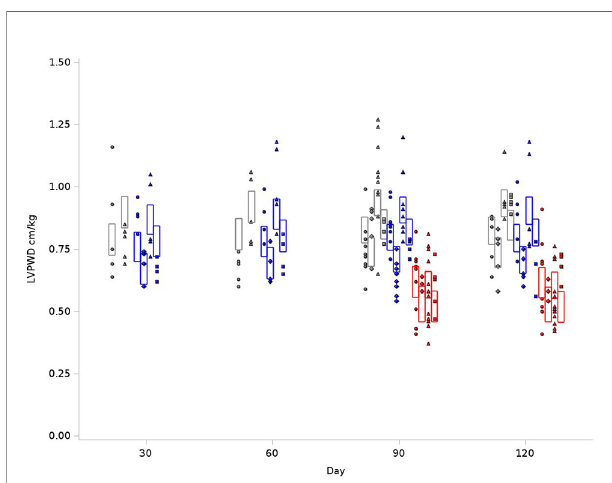
FIGURE 5 | Graphical representation of values for Left Ventricular Posterior Wall Thickness at End Diastole (LVPWD) in rats at 4 time points (X-axis). The rats were measured at 4 time points: 30, 60, 90 and 120 days. The values observed are represented by symbols denoting the experimental treatment: Circle (No Radiation and No Lisinopril -R-L), Diamond (No Radiation and Lisinopril -R+L), Triangle (Radiation and No Lisinopril +R-L), or Square (Radiation and Lisinopril +R+L). The colors represent the strain: Brown- Norway (BN: black), Salt-Sensitive (SS: blue) and SS with BN chromosome 6 (SSBN6: red). The rectangles are 95% Con fi dence Intervals for LVPWD from a Repeated Measures linear model for treatment that included time, strain and the SSBN6 by radiotherapy interaction. There was 14-15% increase in LVPWD in SS and BN (p<0.0001), but not SSBN6 rat hearts at 120 days, while lisinopril reduced LVPWD in all groups of irradiated rat hearts